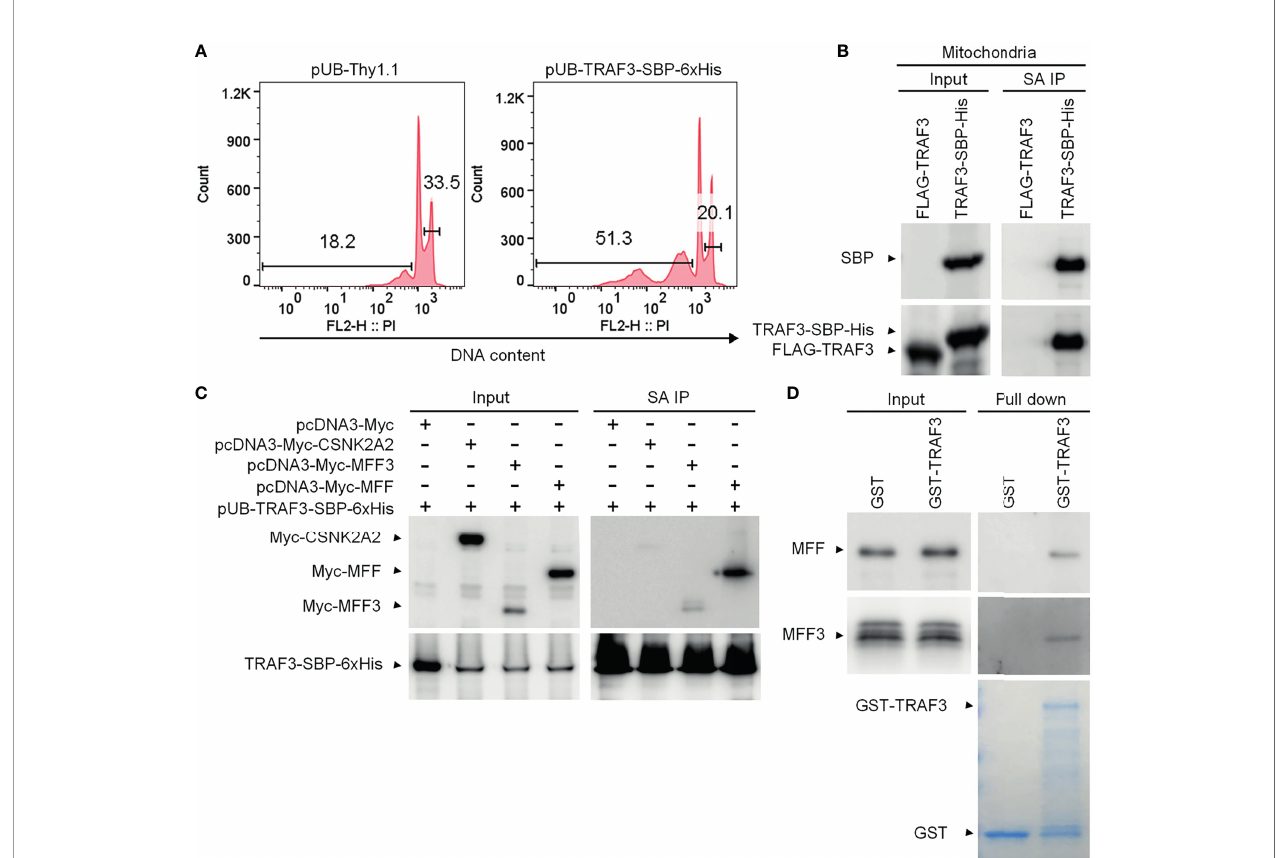
FIGURE 2 | MFF is a novel TRAF3-interacting protein. (A) Validation of the functionality of C-terminally SBP-6xHis-tagged TRAF3 in human MM 8226 cells. Reconstitution with the lentiviral expression vector pUB-TRAF3-SBP-6xHis induced apoptosis in 8226 cells as demonstrated by the cell cycle analysis. Cells transduced with an empty lentiviral vector (pUB-Thy1.1) were used as a control. Cell cycle analysis was performed by PI staining and FACS at day 7 post transduction. Gated populations indicate apoptotic cells with DNA fragmentation (DNA content < 2n) and proliferating cells (2n < DNA content ≤ 4n). (B) Large scale af fi nity puri fi cation of SBP-6xHis-tagged TRAF3 from isolated mitochondria of transduced 8226 cells. Cells were harvested at day 4 post transduction and were fractionated to isolate mitochondria. Mitochondrial proteins were immunoprecipitated with Streptavidin (SA)-Sepharose beads. Immunoprecipitates of TRAF3-SBP- 6xHis (SA IP) from the mitochondrial proteins were analyzed by immunoblotting and used to identify TRAF3-interacting proteins by LC-MS/MS-based sequencing. Immunoblots of mitochondrial proteins before immunoprecipitation were used as the input control. Cells transduced with FLAG-TRAF3 were used as a negative control for SA IP. (C) Co-immunoprecipitation of MFF and MFF3 with TRAF3. 293T cells were co-transfected with pUB-TRAF3-SBP-6xHis and pcDNA3-Myc-MFF, pcDNA3-Myc-MFF3, pcDNA3-Myc-CSNK2A2 or an empty expression vector pcDNA3-Myc. Transfected cells were harvested at day 2 post transfection and total cellular proteins were immunoprecipitated with Streptavidin-Sepharose beads. Immunoprecipitates (SA IP) were immunoblotted for the Myc tag followed by the SBP tag. Bands of Myc-tagged proteins are indicated. (D) MFF and MFF3 pulled down by GST-TRAF3. Pre-cleared whole cell lysates of 293T cells transfected with pcDNA3-Myc-MFF or pcDNA3-Myc-MFF3 were subjected to the pull-down assay by GST alone or GST-TRAF3 fusion protein in the presence of Glutathione- Sepharose beads. GST and GST-TRAF3 used for pull-down were analyzed by SDS-PAGE and visualized by GelCode blue staining (the bottom panel). Lysates that were puri fi ed by the same pull-down procedures with GST were used as a negative control. Myc-tagged MFF and MFF3 in the input lysates and pull-down proteins were detected by immunoblotting (the top panel). Results shown are representative of at least 3 independent